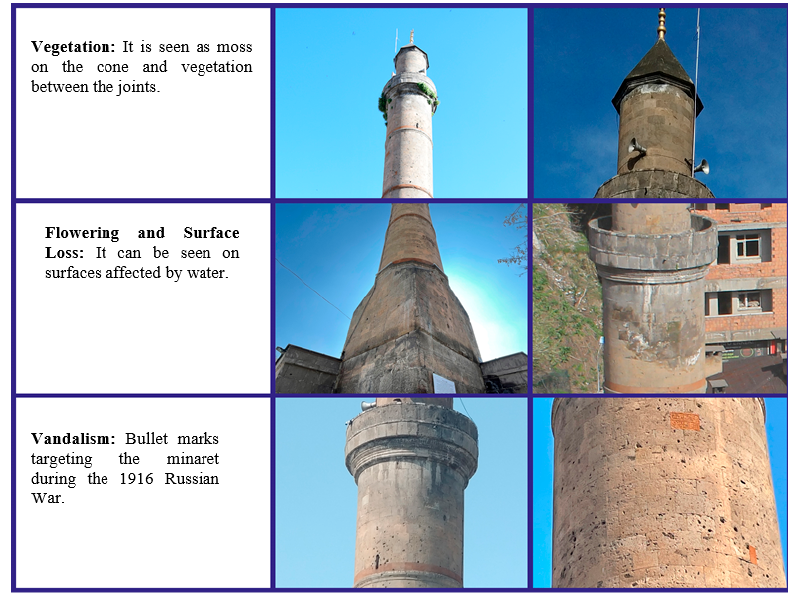
Figure 11. Damages observed on the minaret of the Ulu Mosque.